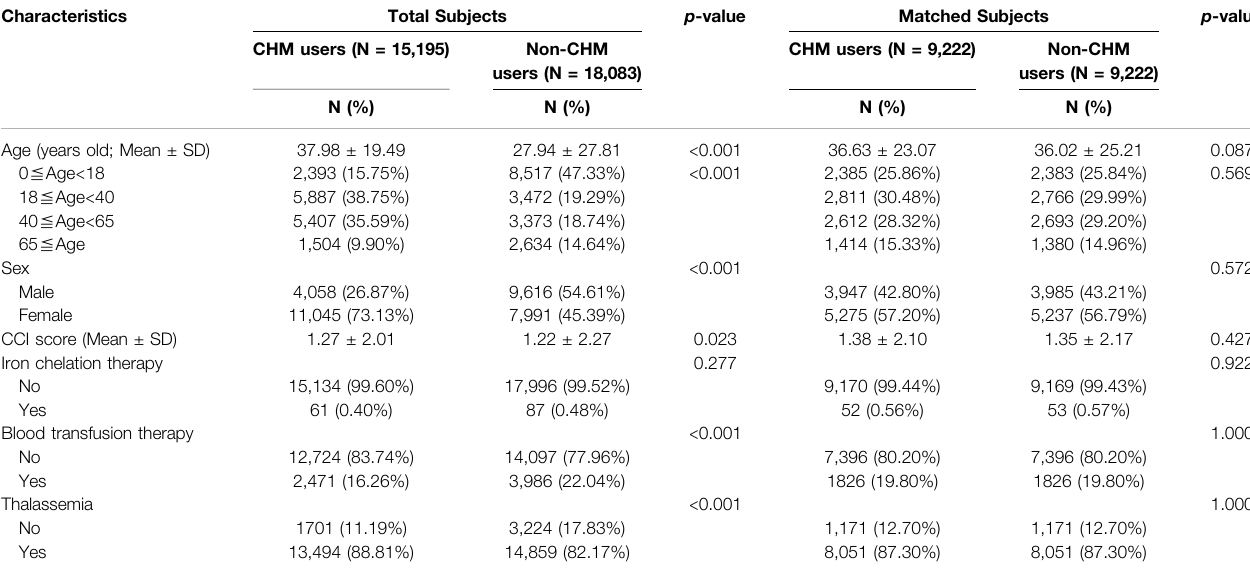
TABLE 1 | Basic characteristics of patients with hereditary hemolytic anemias (HHAs) in Taiwan.